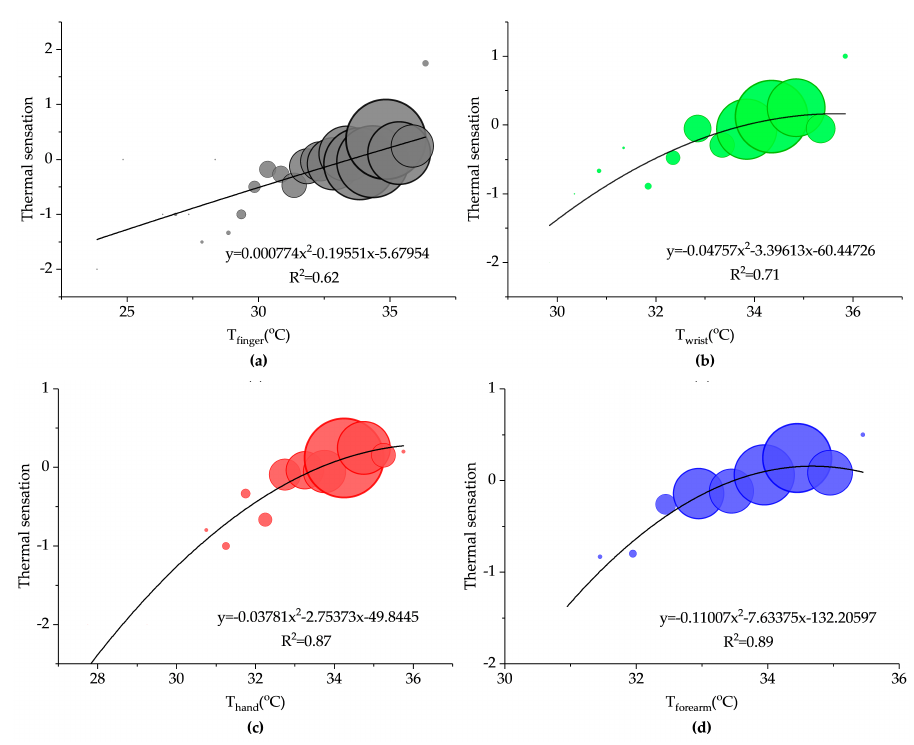
Figure 8. Relationships between the upper extremity skin temperatures and thermal sensation: ( a ) Thermal sensation vs. T finger ( b ) Thermal sensation vs. T wrist ( c ) Thermal sensation vs. T hand ( d ) Thermal sensation vs. T forearm